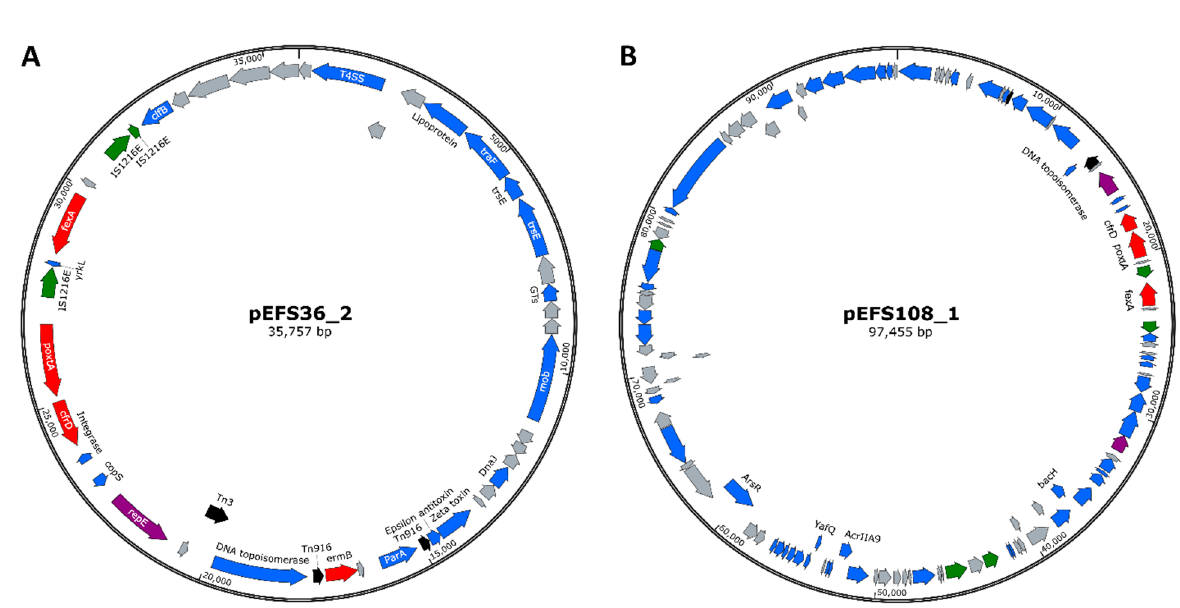
Figure 3. Schematic diagram of genetic structure of poxtA linezolid resistance gene-containing plasmids ( A ) pEFS36_2 from EFS36 isolate and ( B ) pEFS108_1 from EFS108 isolate. Genes and their orientation are indicated by arrow as follows: red, green, black, purple, blue, and gray represent antibiotic resistance gene, ISs, transposase, rep protein, other protein, and hypothetical proteins, respectively. Table 5. Antimicrobial resistance genes in three E. faecalis strains.